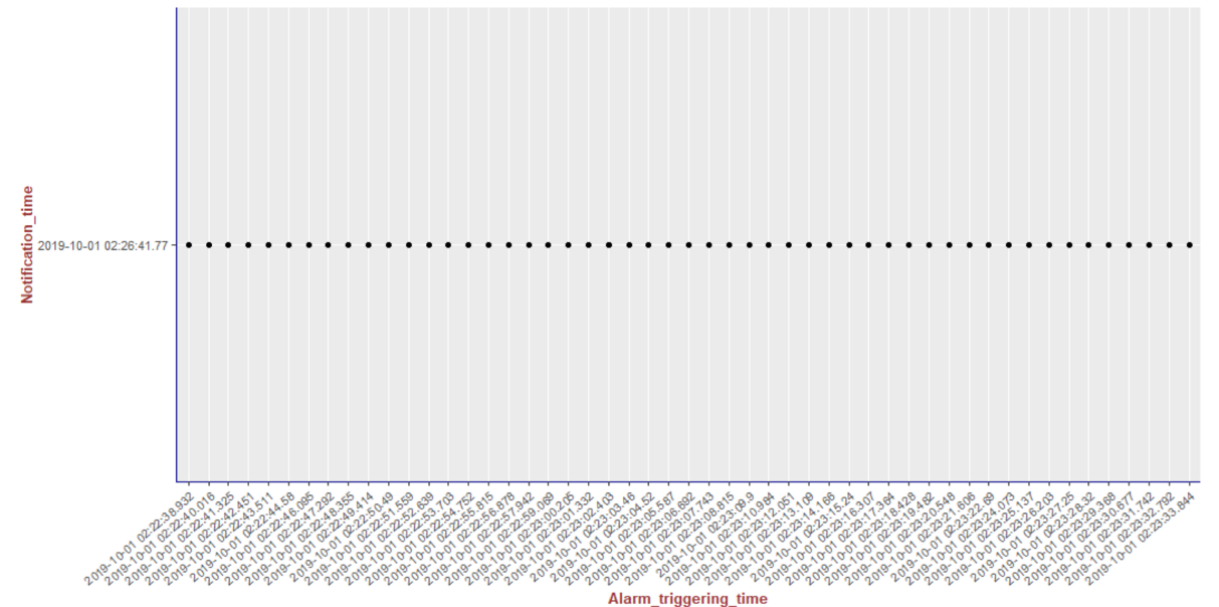
Figure 11. Illustration of the results of the alarm triggering and delivery processes related to the patient monitored in our experiment 5 (PatientID=5).